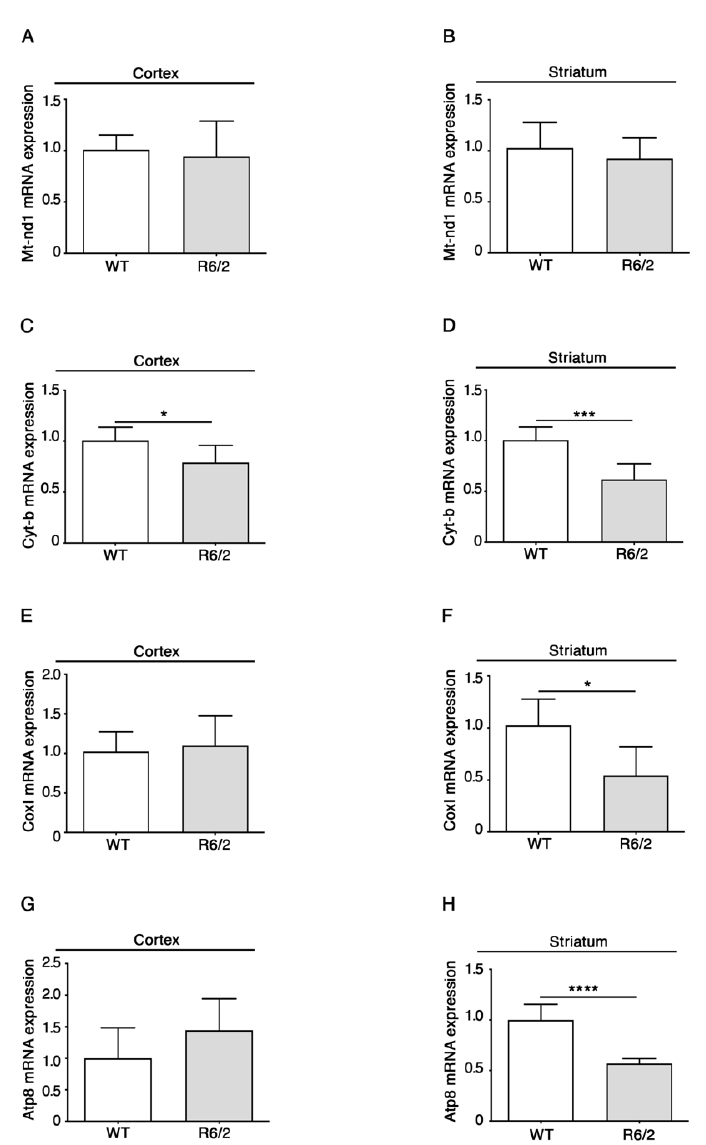
Figure 2. Altered RNA levels of components of the mitochondrial-encoded ETS complex and ATP- synthase genes in brains of 11-week-old R6/2 mice. qPCR analysis of both cortical and striatal Mt-nd1 ( A , B ), Cyt-b ( C , D ), Cox I ( E , F ), Atp8 ( G , H ) are presented. N = 6 for each group of mice. Data are represented as mean ± SD. * p < 0.05; *** p < 0.001, **** p < 0.0001 (Unpaired t -test). The raw data used for generating the figure are reported in the Supplementary Materials Table